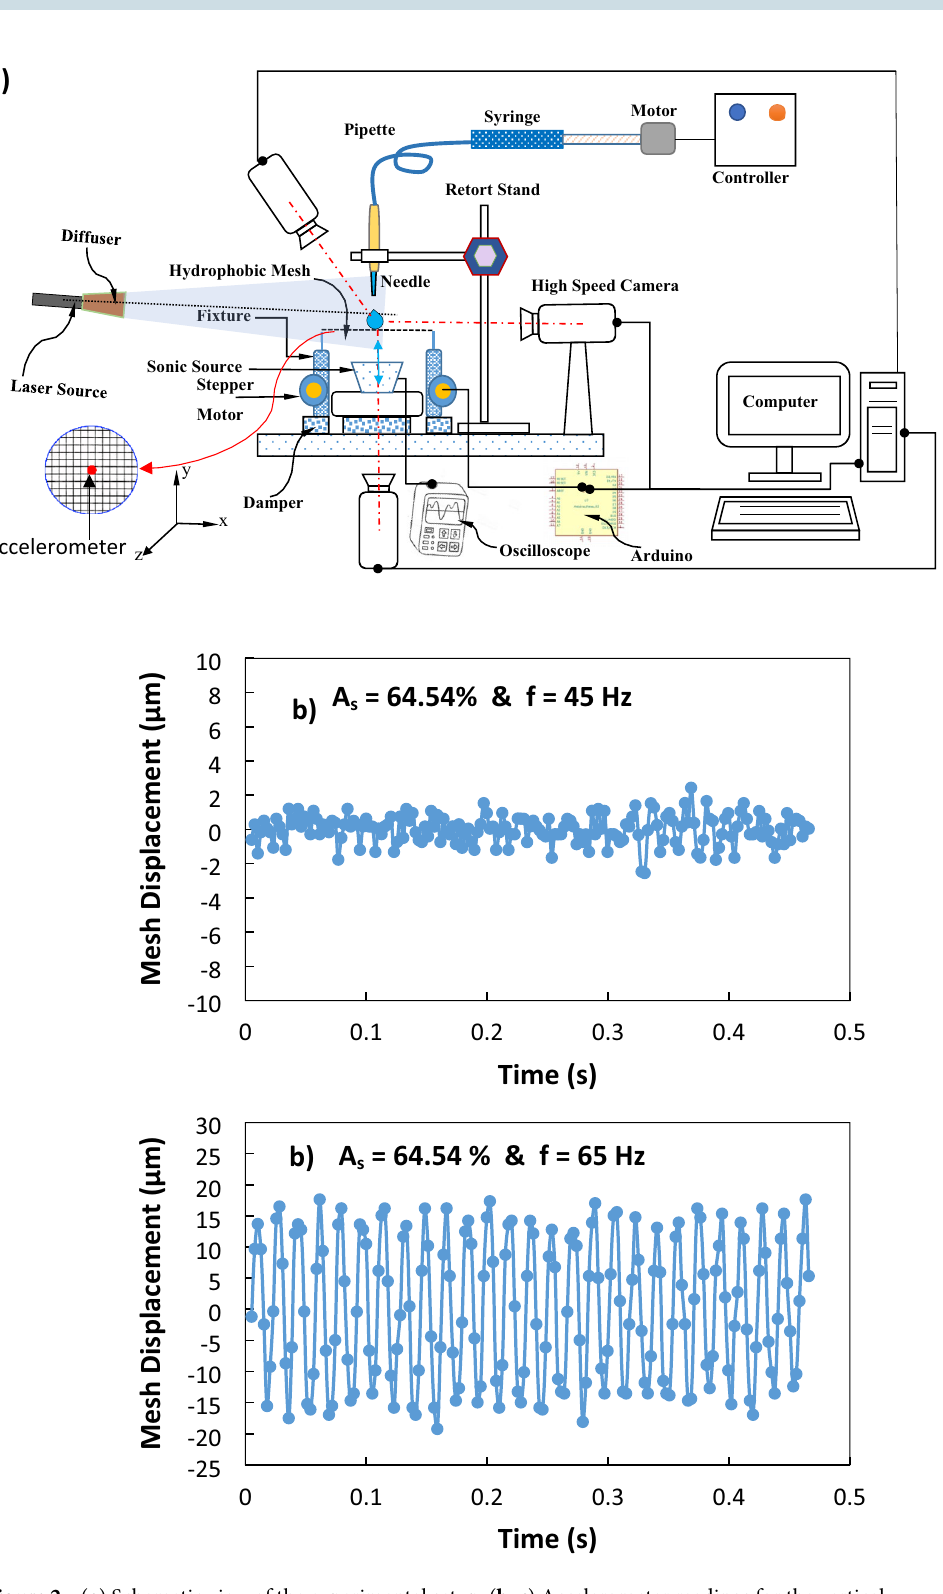
Figure 2. ( a ) Schematic view of the experimental setup. ( b , c ) Accelerometer readings for the vertical displacement of mesh screen structure with A s = 65.54% and frequency of: ( a ) 45 Hz and ( b ) 65